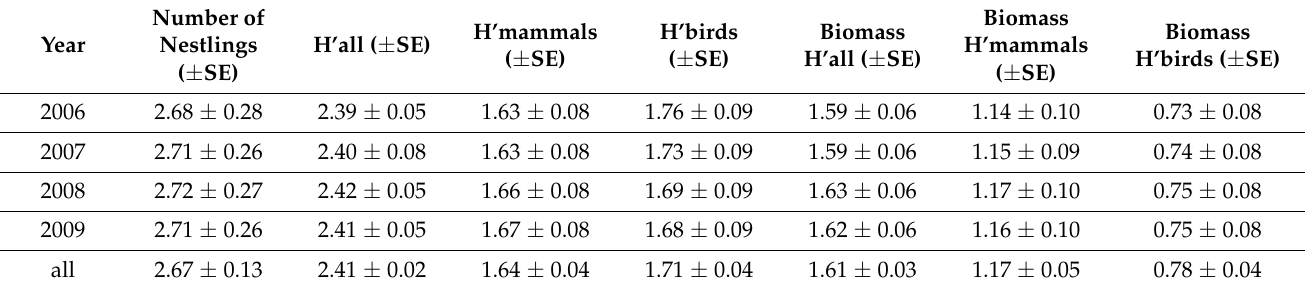
Figure 2. Relationship between the birds and mammals diversity in the diet of Eagle Owls during the 2006–2009 breeding seasons. ( A ): H’ for prey abundance, ( B ): biomass of birds and mammals. Overall, 43 breeding attempts from 14 nest sites (mean 2.5 breeding attempts/nest + 0.39 SE) were monitored during the 2006–2009 breeding seasons (Table 1). Table 1. Results of the Shanon-Wiener Diversity Index for the effect of prey-base composition on prey diversity and breeding success in Eagle Owl ( Bubo bubo ) in the Judea region, central